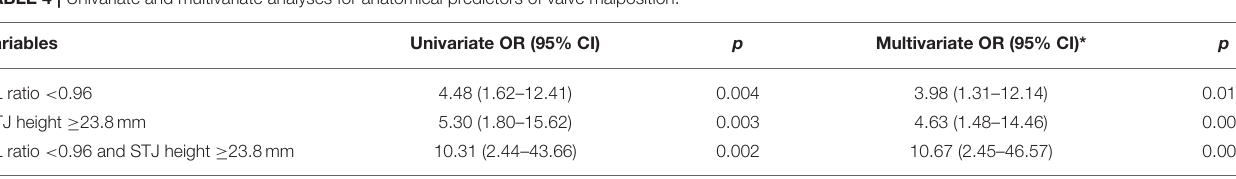
FIGURE 2 | ROC curves of AL ratio, STJ height, and the combination of both for prediction of valve malposition. AL, annulus perimeter/left ventricular outflow tract perimeter; AUC, area under the curve; ROC, receiver operating characteristic; STJ, sinotubular junction. TABLE 4 | Univariate and multivariate analyses for anatomical predictors of valve malposition.